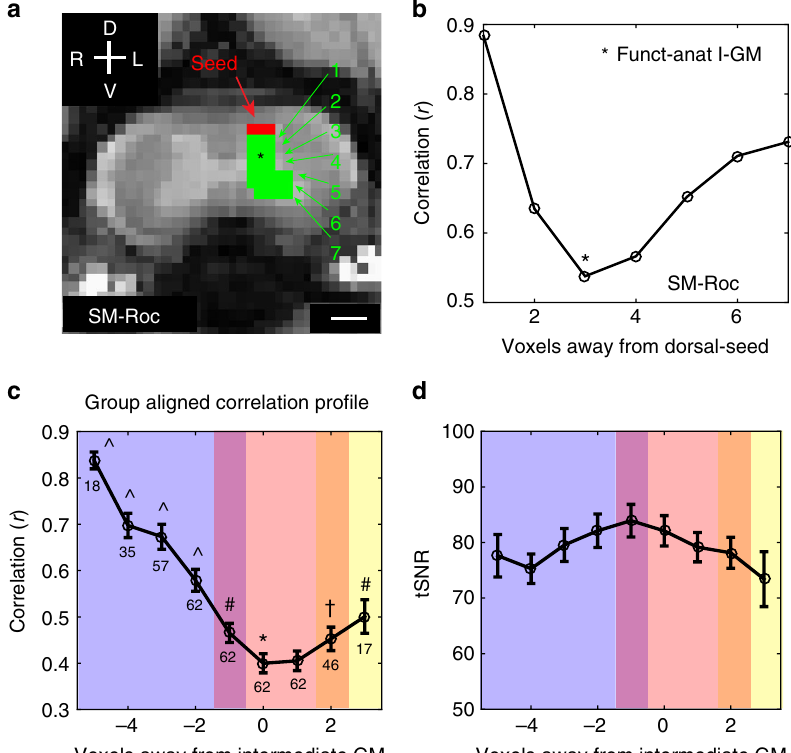
Fig. 4 Local dorsal-to-ventral correlation pro fi le. a ROIs de fi ned in one representative monkey on one side of the spinal cord. Mean time series of the dorsal region (red voxels) was used as a seed to compute mean Pearson ’ s cross-correlations with voxels from each depth (green voxels); depth numbers are indicated by the green numbers. Scale bar represents 1 mm. b An example of an observed U-shaped pro fi le from SM-Roc. Asterisk (*) represents de fi ned intermediate GM (I-GM) seeds based on functional and anatomical features; greatest difference of connectivity value to the dorsal horn seed. c Group- averaged aligned correlation pro fi le based on each run ’ s anatomically functionally de fi ned seed of the intermediate GM region for both left and right sides of the spinal cord. Error bars represent standard error of mean. The number of observations for each distance are indicated below each scatter circle. Data points representing four voxels away from I-GM were removed as they contain only fi ve observations. Blue, red, and yellow shades represent estimated dorsal, intermediate, and ventral boundaries de fi ned based on two-sided Mann – Whitney test comparisons (corrected for false discovery rate) relative to the de fi ned I-GM seed; ^ p < 0.000005; # p < 0.05; † p < 0.1. Shades of overlaid colors — purple and orange — represent an estimated overlap of dorsal-IGM and ventral-IGM, respectively. Supplementary Tables 1 and 2 provide uncorrected and corrected p -values for Mann – Whitney Tests and r-values, respectively. d Group-averaged tSNR at different depths of the spinal cord used to compute ( c )